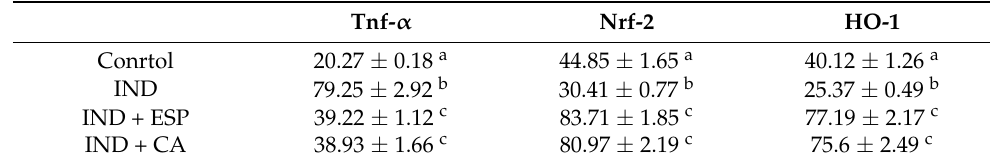
Table 3. Effects of CA on IND-induced TNF- α , Nrf-2 and HO-1